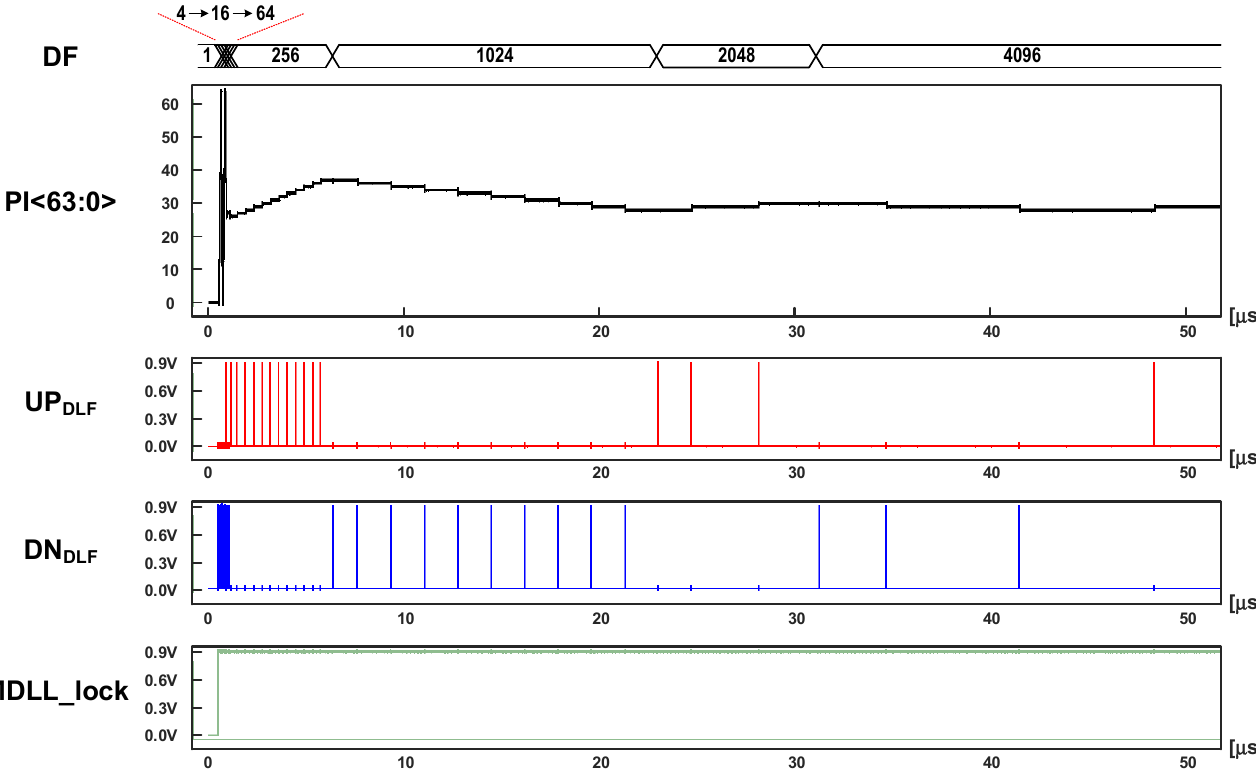
9 of 12 Figure 9. Chip layout of the proposed all-digital DJA.